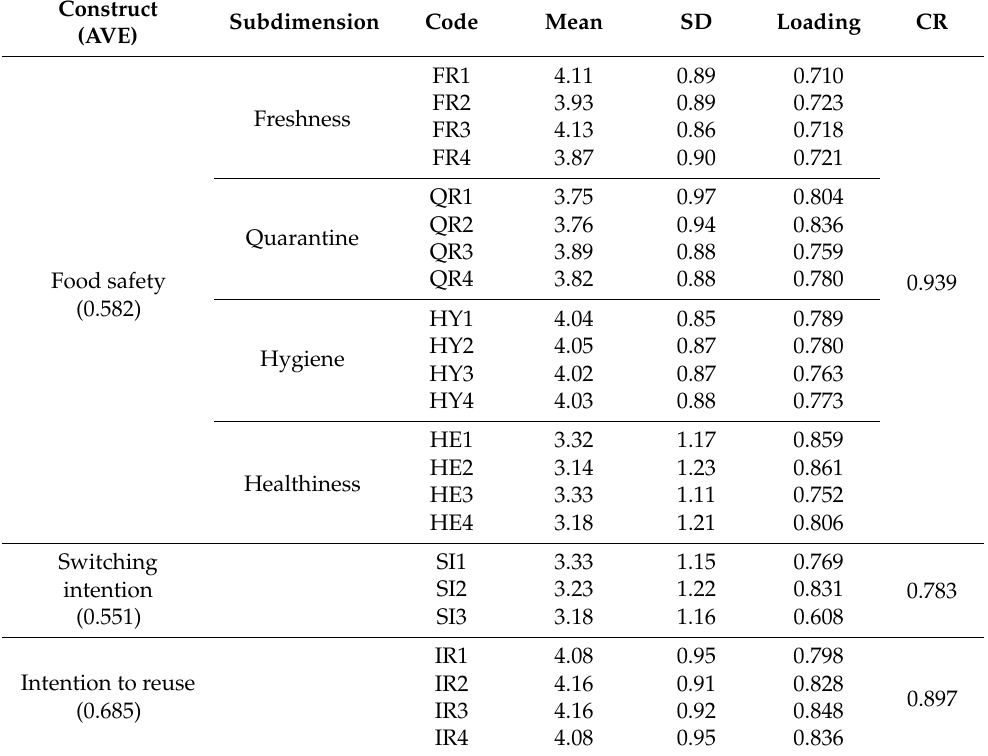
Table 3. Measurement items.